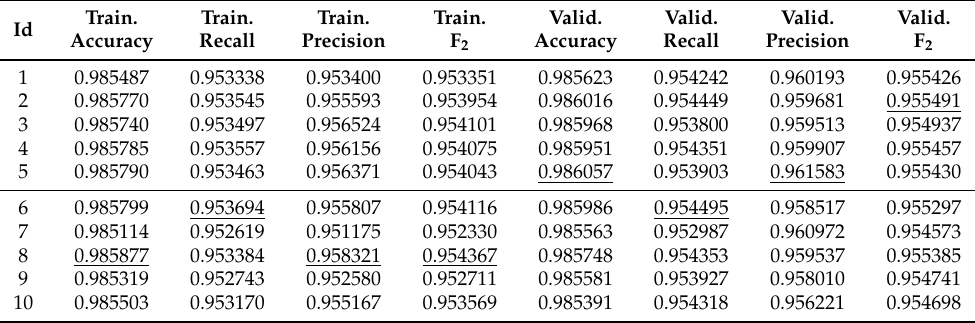
Table 4. Results of best model configurations on a complete dataset (the highest values are